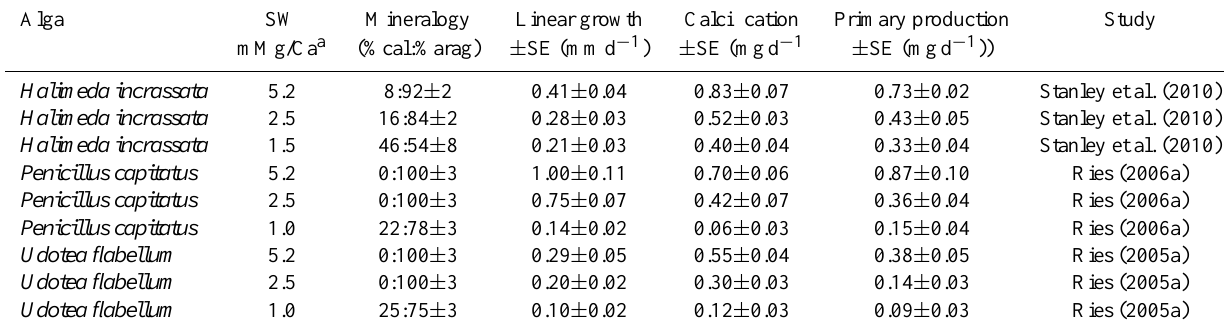
Table 1. Summary of mineralogy, linear growth, calcification, and primary productivity for Halimeda incrassata , Penicillus capitatus , and Udotea flabellum algae grown in experimental seawater treatments formulated at different Mg/Ca ratios.